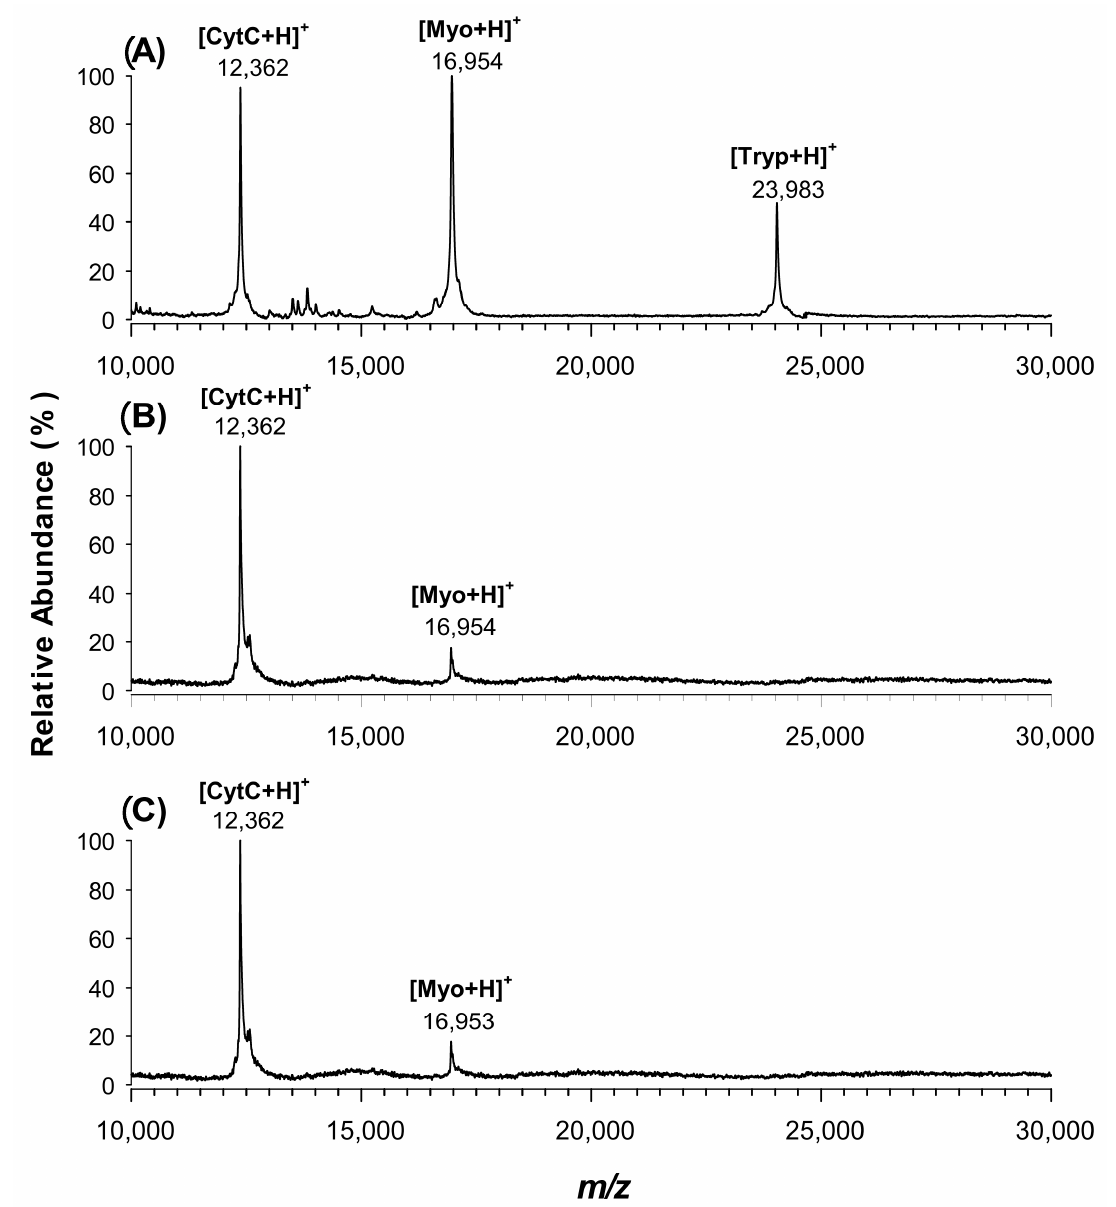
Figure 3. Positive MALDI-TOF MS spectra of a standard equimolar (100 fmol / µ L) mix of cytochrome c (cytC), bovine myoglobin (Myo) and trypsinogen (Tryp) using ( A ) CPPA, ( B ) CHCA or ( C ) CClCA as the matrix.